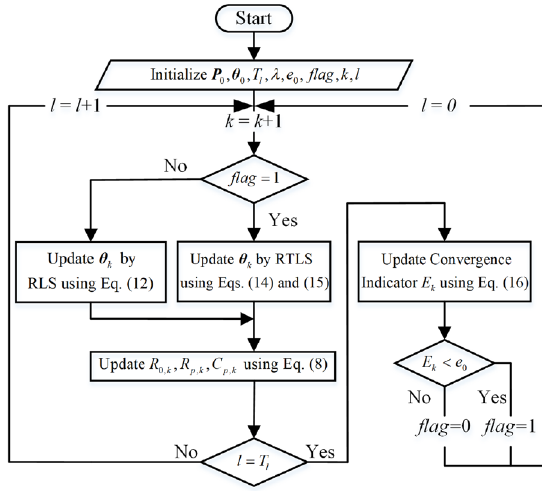
Figure 5 Flowchart of the proposed parameter identification